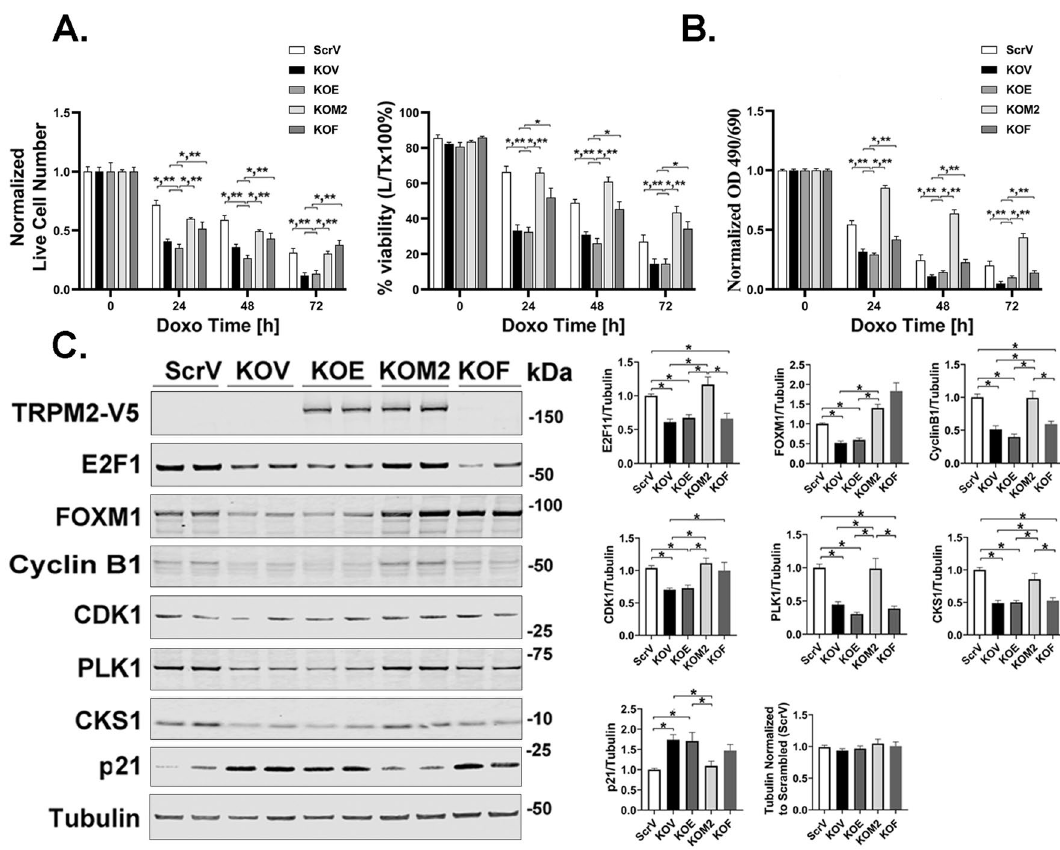
Figure 5. Reconstitution of TRPM2 in KO cells restores viability and expression of cell cycle proteins. TRPM2 KO SH-SY5Y cells were stably transfected with empty vector (KOV), TRPM2 calcium impermeant mutant E960D (KOE), wild type TRPM2 (KOM2), or FOXM1b (KOF). Live cell number and viability were measured after treatment with 0.3 µM doxorubicin for 0–72 h with trypan blue exclusion ( A ) and XTT analysis ( B ). Results were normalized to time 0. Percent viability was calculated as live divided by total cell number × 100%. ( A , B ) Mean ± S.E.M for two experiments (n = 12–24). Statistics: two-way ANOVA. *p < 0.0001, indicates significant differences between Scr vs KO, Group Effect; **p < 0.0001, group x doxorubicin exposure time interaction effect (indicates the differences between groups significantly increased with time of doxorubicin exposure). ( C ) Western blotting was performed on lysates from two clones for each group after doxorubicin treatment for 24 h. Blots were probed with antibody to V5 to demonstrate successful transfection of TRPM2 E960D or M2, and antibodies to E2F1, FOXM1, Cyclin B1, CDK1, PLK1, CKS1, p21, and tubulin. Samples (ScrV, KOV, KOE, KOM2, KOF) were derived from the same experiment and always processed in parallel. One blot of four to five experiments is shown. The different probes for each antibody are made explicit with white space and delineated with a black box. Mean ± S.E.M. densitometry measurements of the four to five experiments with 2 clones for each protein in each experiment (n = 8–10) are shown. Measurements were standardized to tubulin and to each experiment’s average scrambled control. Statistics: one-way ANOVA, *p < 0.05. Full length gels for Western blots are shown in Supplementary Fig. and doxorubicin treated neuroblastoma cells. Here, the amount of DNA damage was similar between untreated control and cells with TRPM2 deletion (Fig. 6A). Doxorubicin treatment significantly enhanced DNA damage (longer Comet tails) in TRPM2 KO cells but not in scrambled control cells (Fig. 6A, *p < 0.05). Reduced DNA repair may manifest as enhanced DNA damage. Expression of the DNA repair genes CHEK1, WEE1, BRCA1, FANCD2 and PARP1 was significantly reduced in cells with TRPM2 deletion after doxorubicin treatment, both at the RNA (Fig. 6B) and protein level (Fig. 6C). Phosphorylated and total CHEK1 and phos- phorylated protein kinase ATR, involved in sensing DNA damage and activating DNA damage checkpoints, were also reduced in cells with TRPM2 deletion (Fig. 6C). Reconstitution of TRPM2 with wild type but not E960D mutant restored expression of DNA repair proteins and ATR phosphorylation, thereby providing another mechanism (other than modulating expression of cell cycle proteins) by which calcium influx through TRPM2 protects neuroblastoma from doxorubicin injury. Collectively, our data suggest that in cells with TRPM2 deletion treated with doxorubicin, DNA damage is increased through a combination of mechanisms including impaired DNA repair, increased ROS, and down modulation of FOXM1 and E2F1/2, which contribute directly to DNA repair 41–43 . Reconstitution of FOXM1 restored FANCD2, PARP1, and partially WEE1. It is likely that doxorubicin did not cause a significant increase in DNA damage in control Scr cells because ROS levels in those cells are